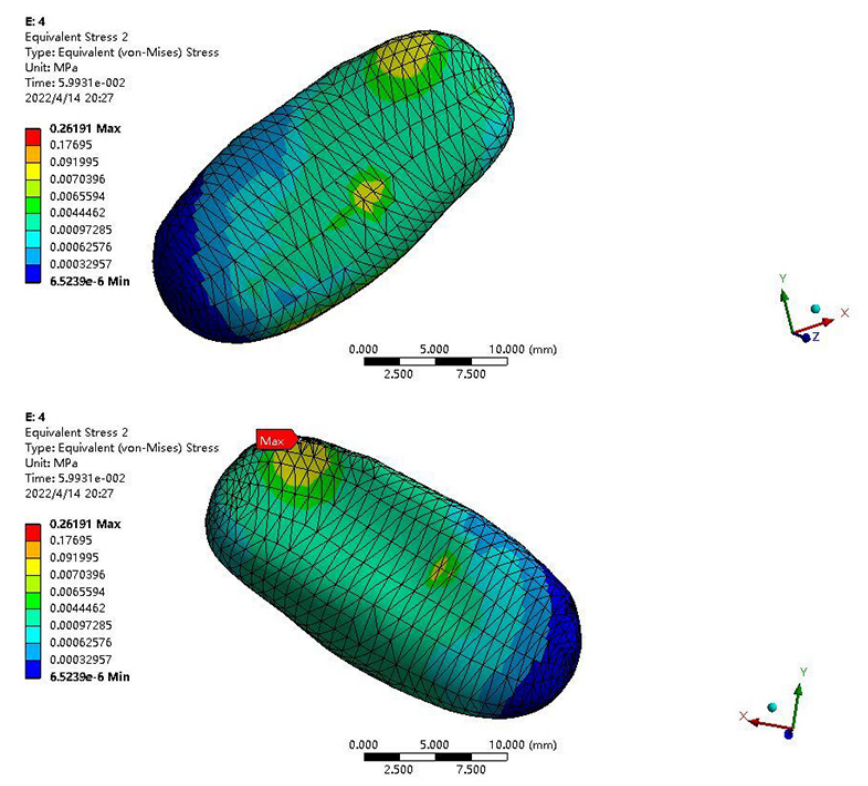
Fig. 6. Stress change at the moment of the subacromial bursa releasing